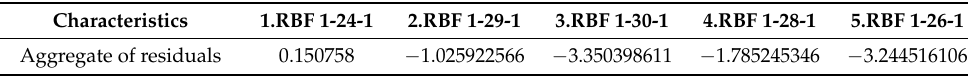
Table 4. Aggregate of the residuals for the individual equalized time series.